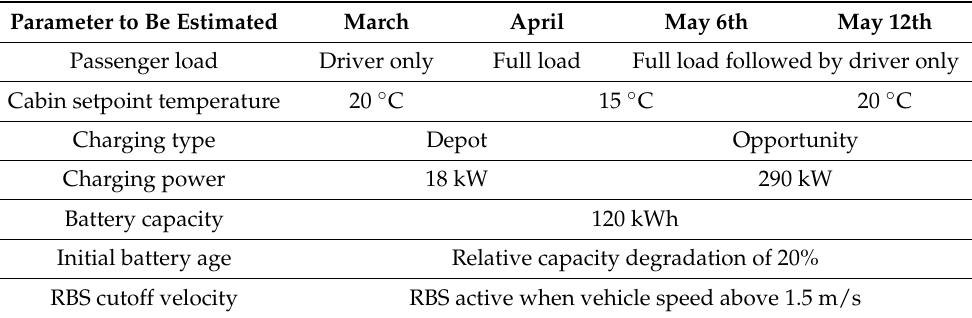
Table 5. Estimation of the driving scenario configuration for the Osnabruck